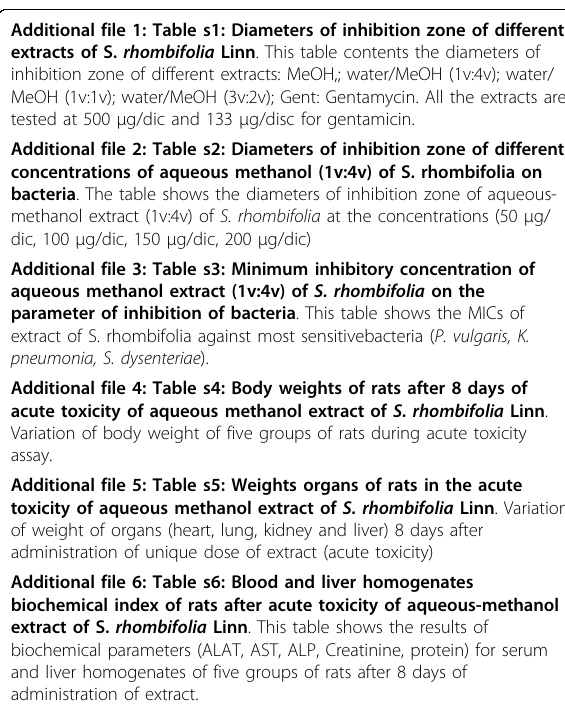
Additional file 4: Table s4: Body weights of rats after 8 days of acute toxicity of aqueous methanol extract of S. rhombifolia Linn . Variation of body weight of five groups of rats during acute toxicity assay. Additional file 5: Table s5: Weights organs of rats in the acute toxicity of aqueous methanol extract of S. rhombifolia Linn . Variation of weight of organs (heart, lung, kidney and liver) 8 days after administration of unique dose of extract (acute toxicity) Additional file 6: Table s6: Blood and liver homogenates biochemical index of rats after acute toxicity of aqueous-methanol extract of S. rhombifolia Linn . This table shows the results of biochemical parameters (ALAT, AST, ALP, Creatinine, protein) for serum and liver homogenates of five groups of rats after 8 days of administration of